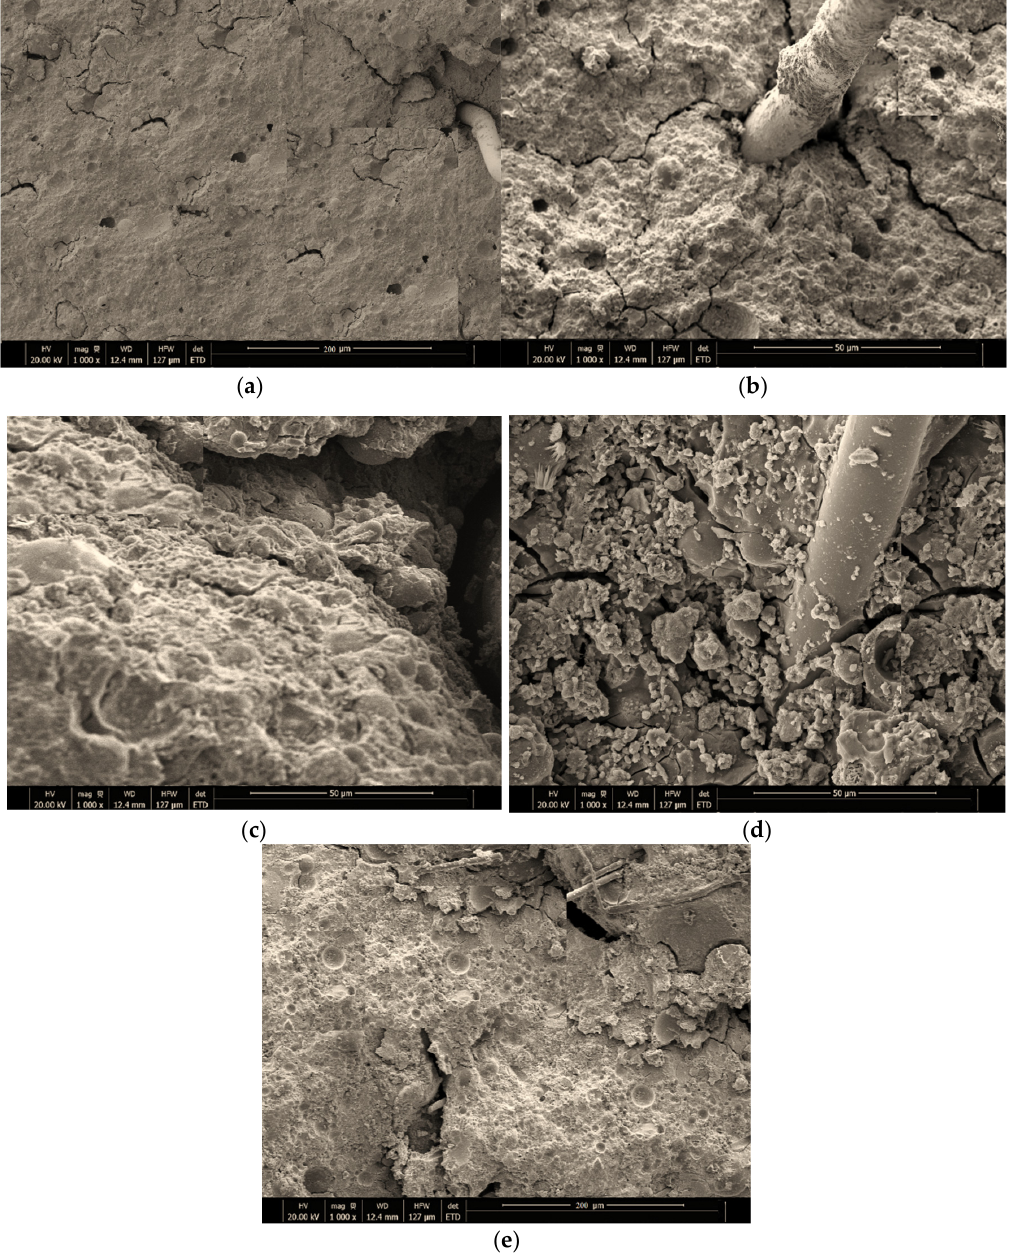
Figure 18. SEM micrographs displaying the microstructures of ( a ) GPO-0%NS, ( b ) GPO-1%NS, ( c ) GPO-2%NS, ( d ) GPO- 3%NS, and ( e ) GPO-4%NS.